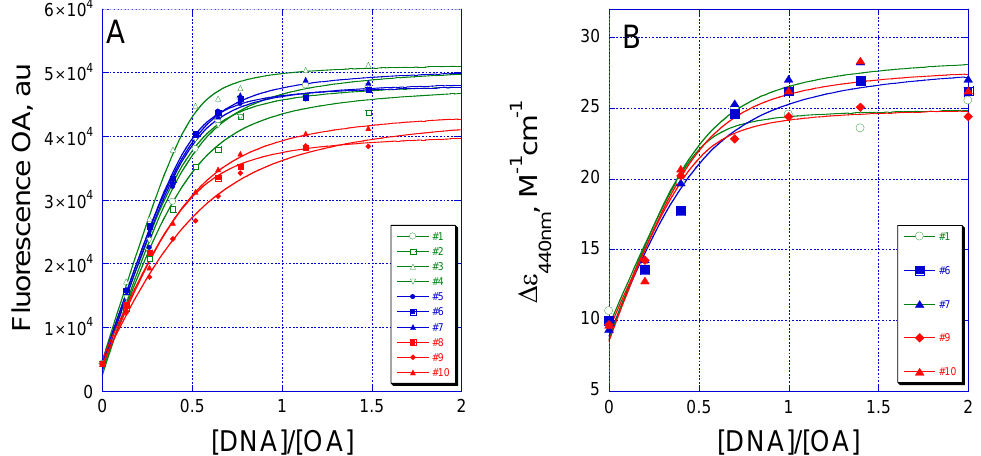
Figure 2. Equilibrium binding of OA to different G/C DNA sites monitored by ( A ) intrinsic fluorescence of bound OA or ( B ) induced CD at 440 nm.